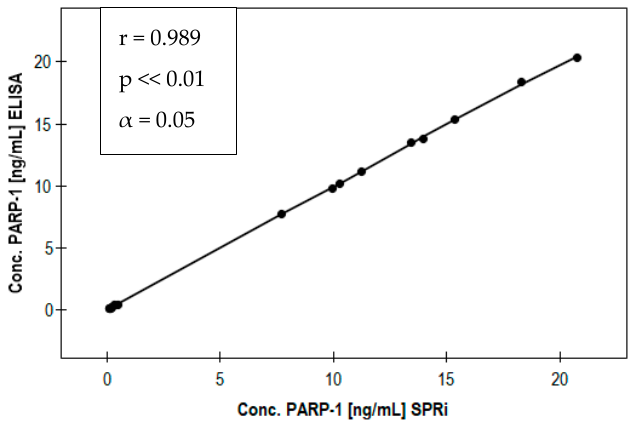
Figure 5. Correlation of the results for the patient and control groups obtained with the SPRi biosensor and ELISA.